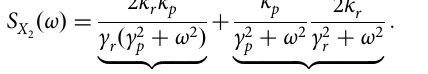
This shows that the PSD (normalised by the total area under its curve) has the fat-tailed Cauchy distribution with in fi nite mean and variance, showing that even for such a simple network the sto- chastic output trajectory contains a very wide range of frequencies.